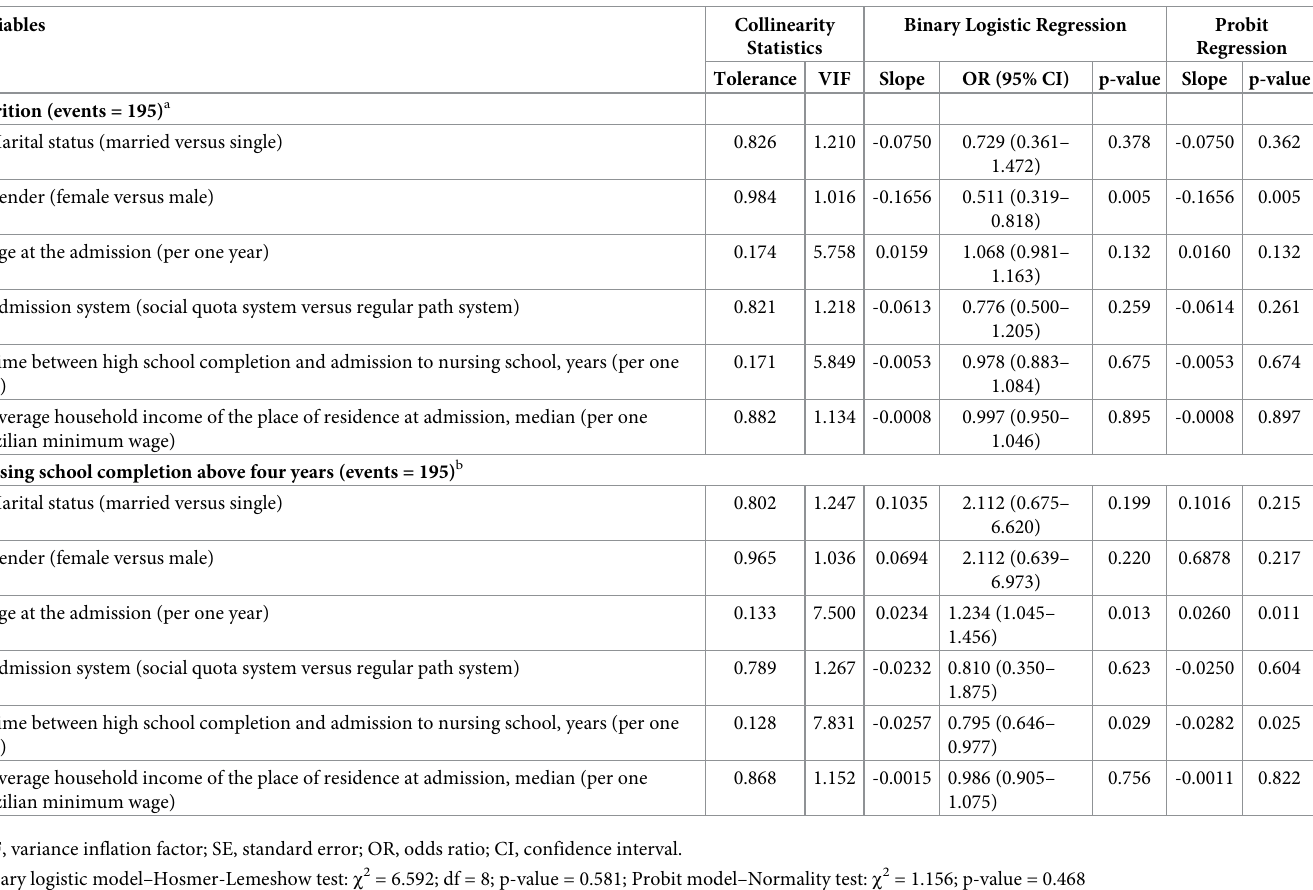
Table 2. Multivariate analysis of nursing school attrition and nursing school completion in more than four years among students admitted to nursing school at the School of Health Sciences (ESCS), Brası´lia, Federal District, Brazil, between 2009 and 2014.